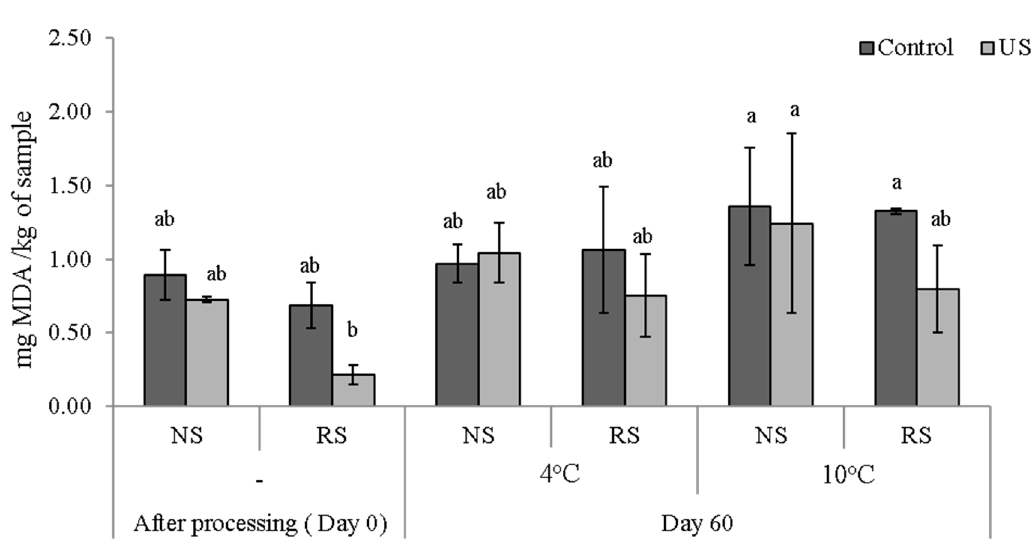
Figure 3. Secondary lipid oxidation values of meat samples with standard sodium content (NS) or reduced sodium content (RS) at Day 0 and after 60 days storage at 4 and 10 °C. Values represent means ± standard deviation (SD, N = 3). Different letters are significantly different at p < 0.05.